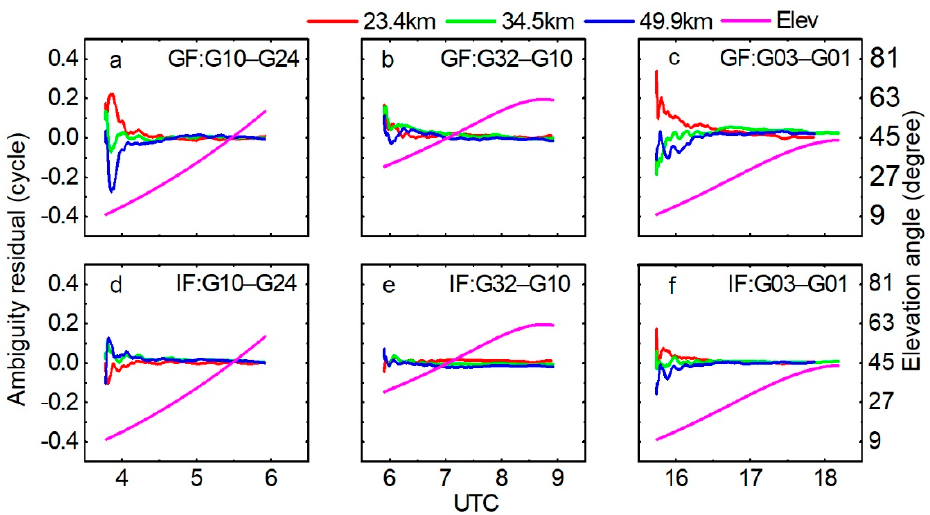
Figure 8. The optimal WL ambiguity residual by GF TCAR method (upper row) and IF TCAR method (lower row), with a smoothing procedure and corresponding satellite elevation angles with GPS data ( a , d ) are the GF and IF of G10–G24; ( b , e ) are the GF and IF of G32–G10; ( c , f ) are the GF and IF of G03–G01. Table 4. The mean RMS and the convergence time of the GPS WL ambiguity.